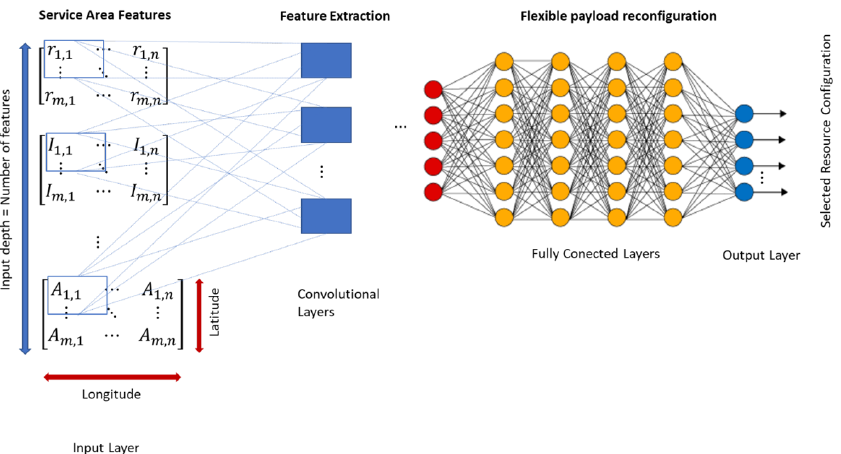
Figure 6. Convolutional neural network for RF interface flexible payload